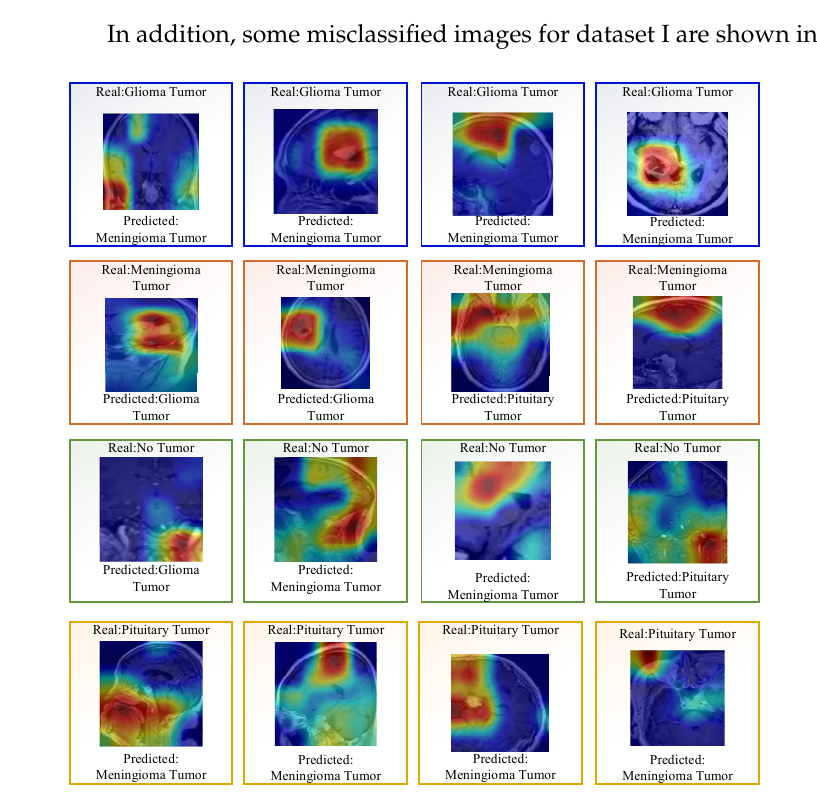
Figure 11. Few misclassified images using Densenet201.